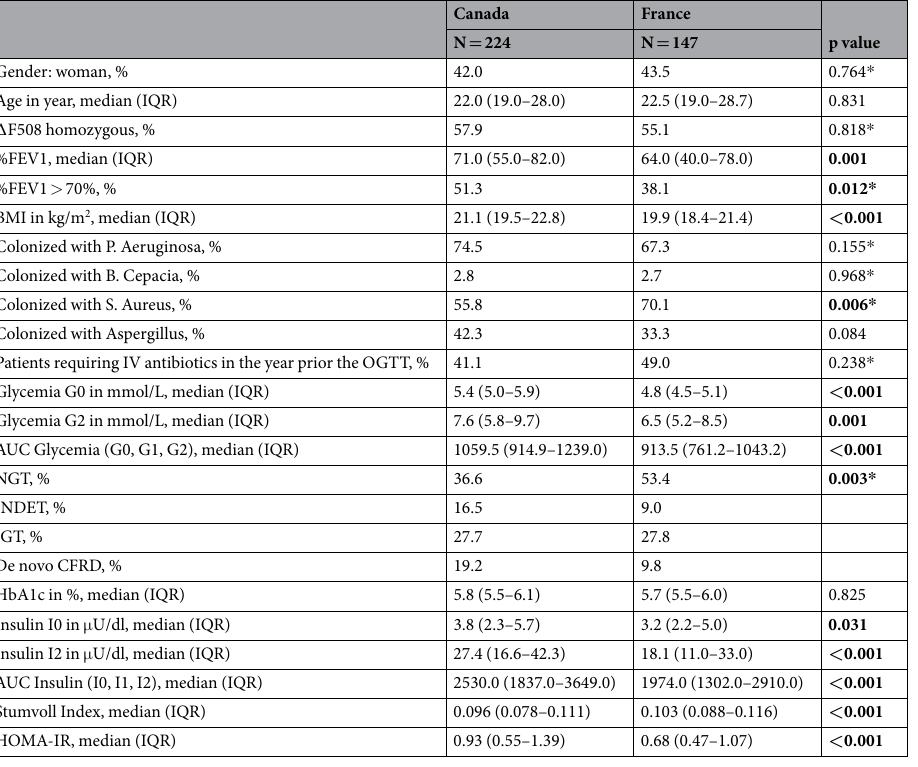
Table 1. Comparison of demographic characteristics and clinical data at inclusion of the Canadian and French patients. Bold values represent significant differences. Abbreviations: AGT: Abnormal glucose tolerance (INDET: indeterminate glucose tolerance + IGT: impaired glucose tolerance), AUC: area under the curve, BMI: body mass index, CFRD: cystic fibrosis-related diabetes, CRP: C reactive protein, FEV1: predicted forced expiratory volume in 1 second, G0: plasma glucose measured at start of OGTT, G2: plasma glucose measured at 2 hours of OGTT, HbA1c: glycated hemoglobin, HOMA-IR: Homeostasis model assessment of insulin resistance, IV antibiotics: number of days of intravenous antibiotics in the year of OGTT, NGT: normal glucose tolerance, P. Aeruginosa: Pseudomonas aeruginosa , S. Aureus: Staphylococcus aureus , * : p value was determined by chi 2